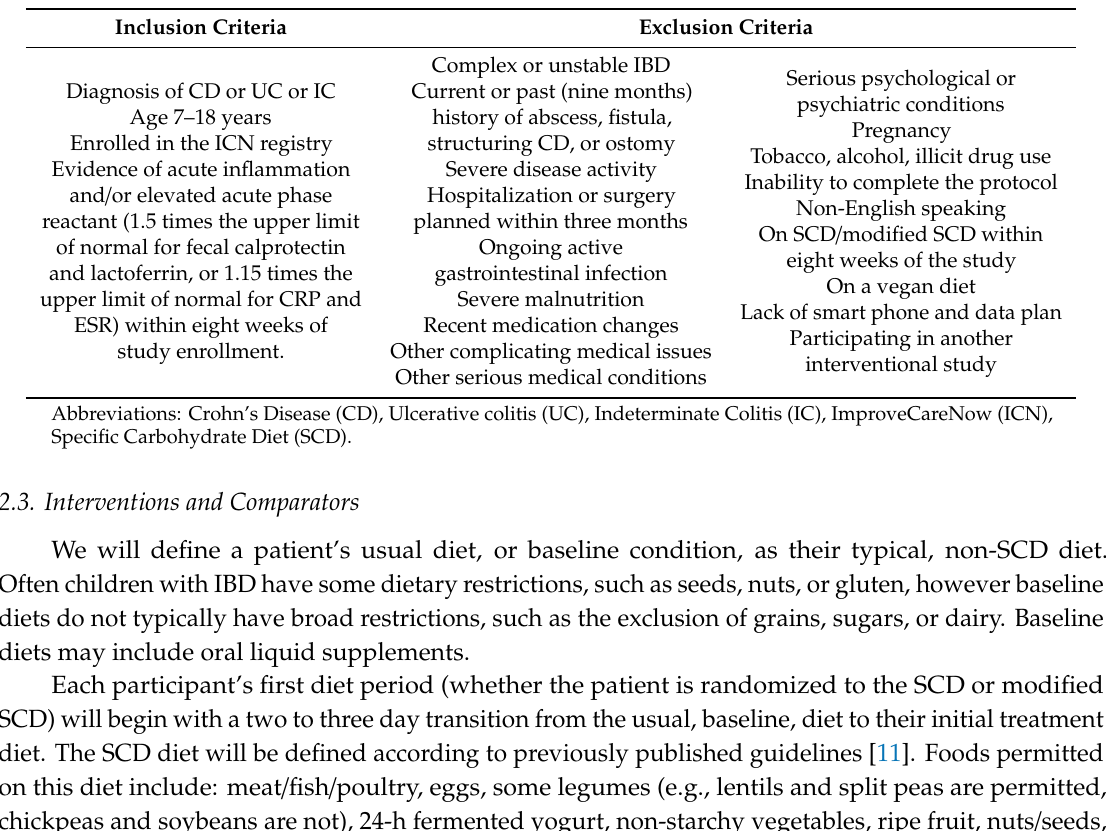
Table 1. Inclusion and exclusion